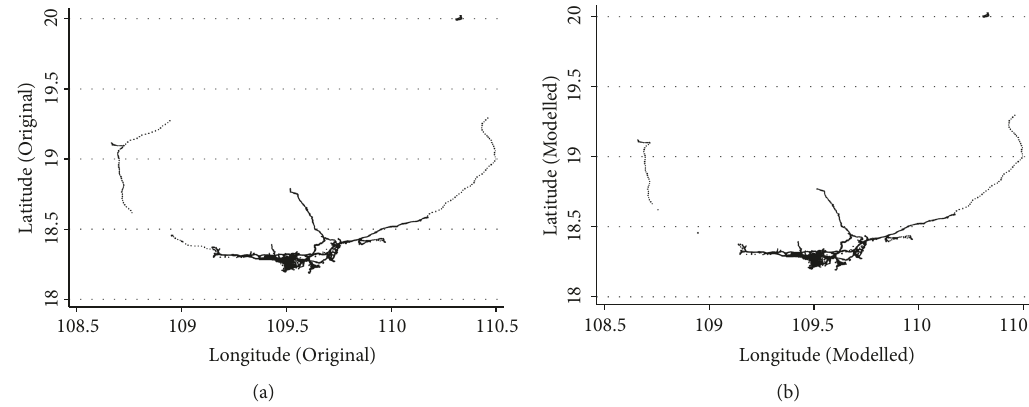
Figure 5: Path comparison of taxi positions located minutely at a fixed monitor where the longitude was in the range of [108 ∘ ,111 ∘ ] while the latitude was in the range of [18 ∘ ,21 ∘ ]. (a) Original positions. (b) Modelled